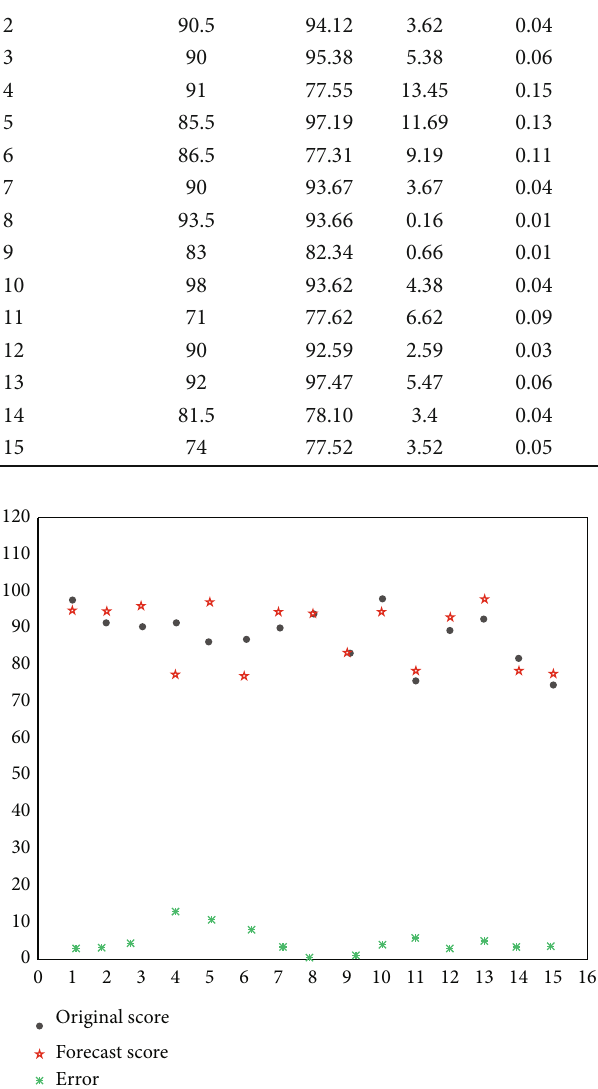
Figure 3: Evaluation results of BP neural